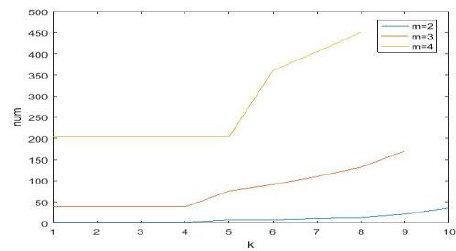
Figure 5. The image of nu m with different k- values.